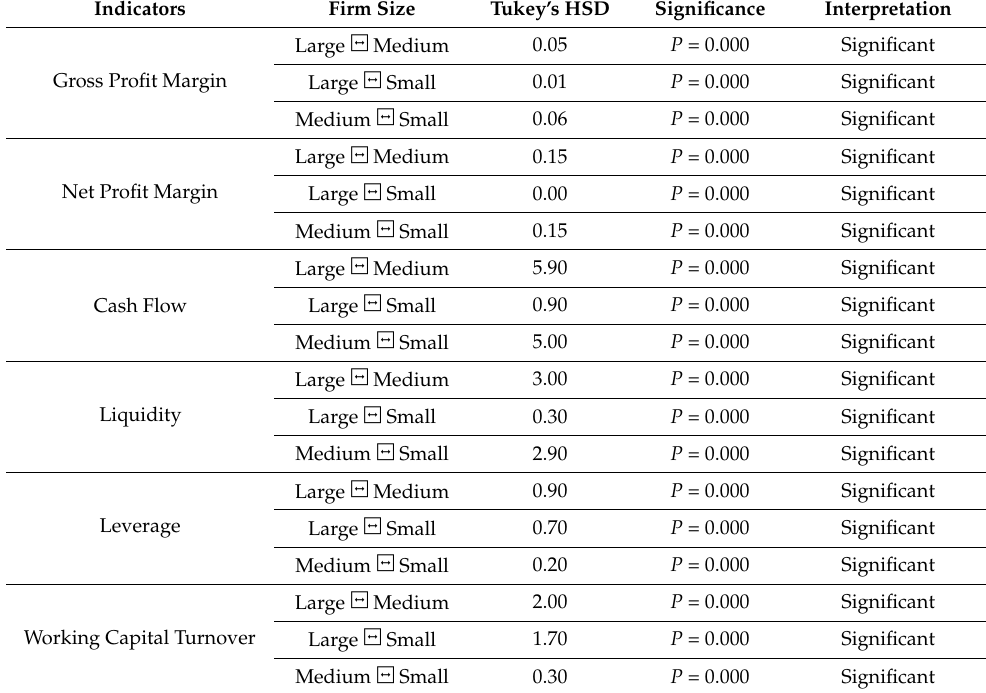
Table 5. Analysis of significant difference of the financial indicators using post hoc Tukey’s HSD.